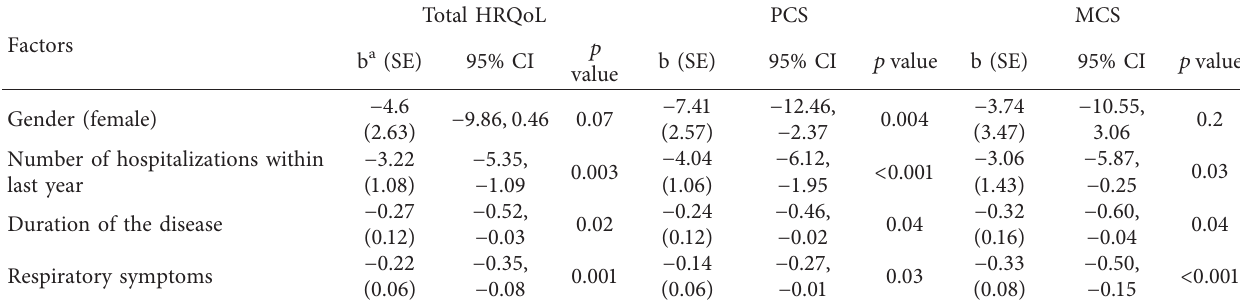
Table 3: Factors affecting the HRQoL in elderly patients with COPD with emphasis on experienced respiratory symptoms.